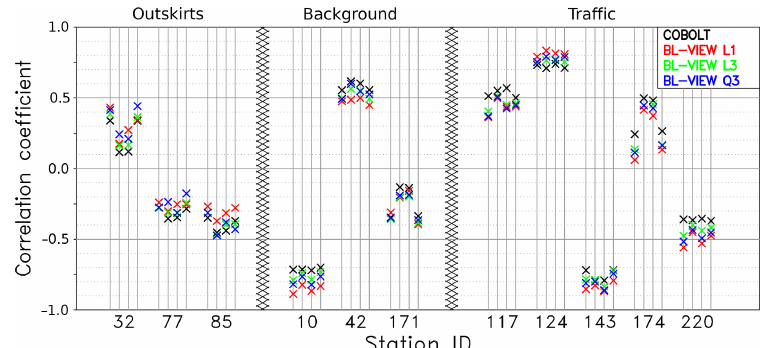
Figure 9. Correlation coefficient R for mean diurnal cycles of MLH and PM 10 for 11 sites (from left to right): sites on the outskirts (32, 77 and 85), urban background sites (10, 42 and 171), and traffic sites (117, 124, 143, 174 and 220). The results of the different retrievals are color coded as indicated in the legend. The four vertical lines of each block correspond to different options of correlation: MLH average vs. PM 10 average (1), MLH median vs. PM 10 median (2), MLH average vs. PM 10 median (3) and MLH median vs. PM 10 average